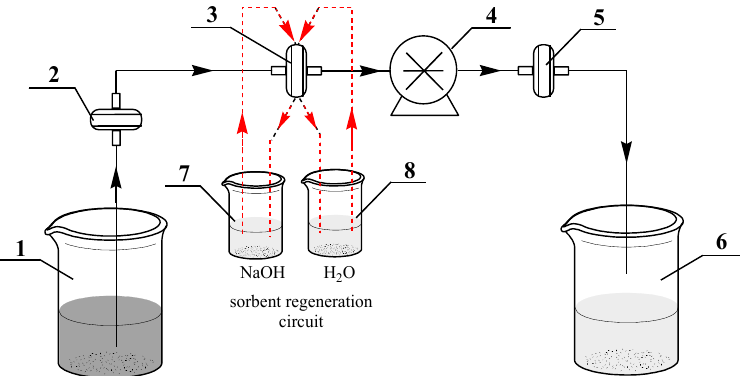
Figure 10. General scheme of the laboratory setup for studying the As(III) sorption performance activity of the composite TeMs. (1) As(III)-contaminated feed solution, (2) coarse prefilter, (3) membrane fine filter, (4) peristaltic pump, (5) final coarse filter, (6) container–receiver of purified water, (7) tank with regeneration solution, and (8) distilled water.